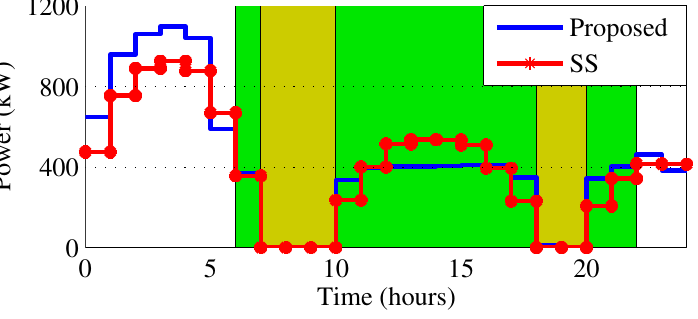
Figure 14. Power consumption of optimized schedules.